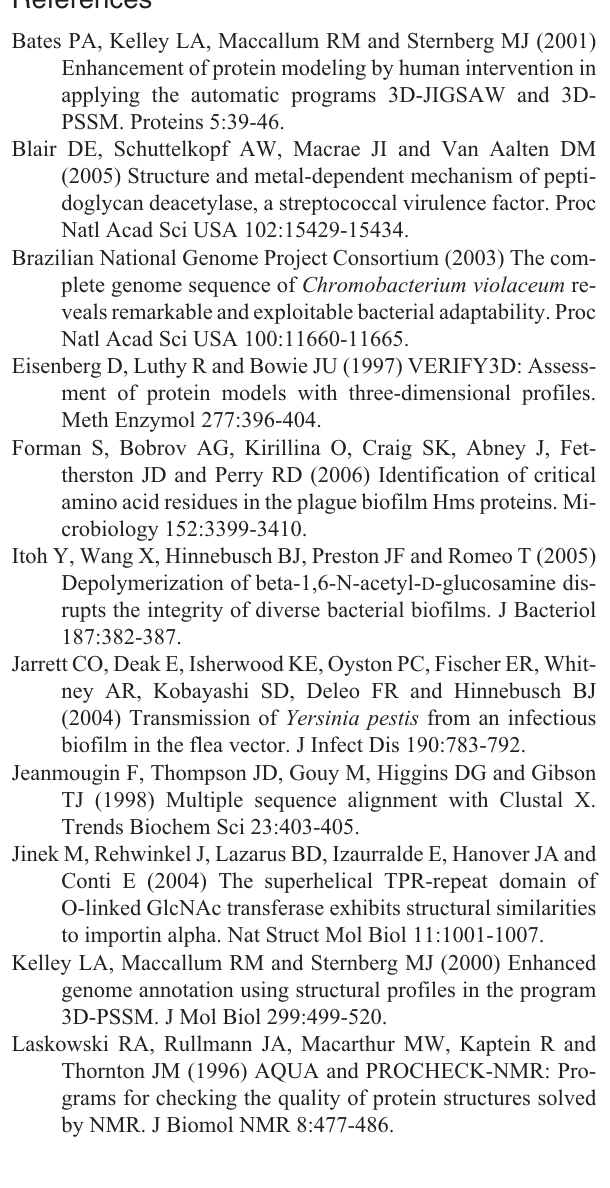
Figure 4 - Superimposed proteins Sp PgdA and HmsF. The residues of Sp PdgA are in green, the HmsF residues are in red and Zinc is in